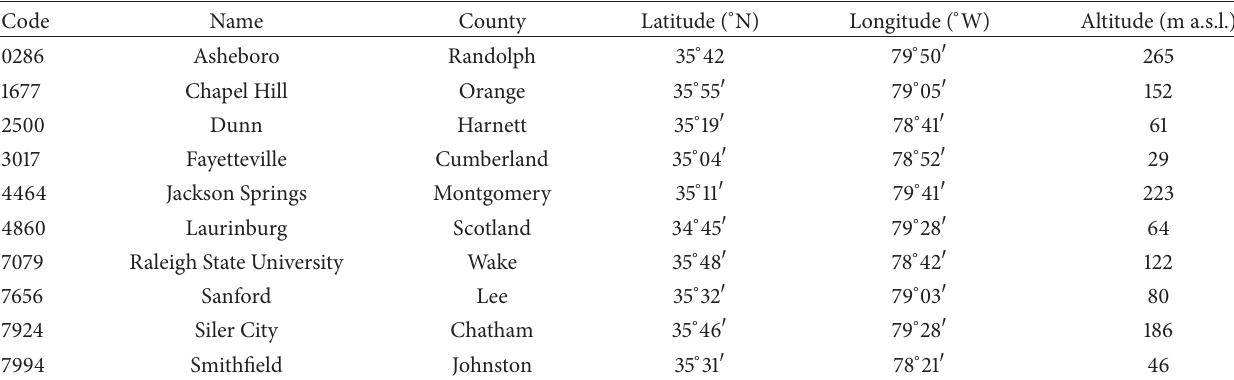
Table 3: List of weather stations used in this